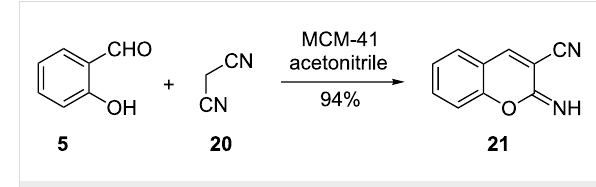
Scheme 13: Synthesis of 2-aminochromenes 22 and 37 by Ghorbani- Vaghei and co-workers.